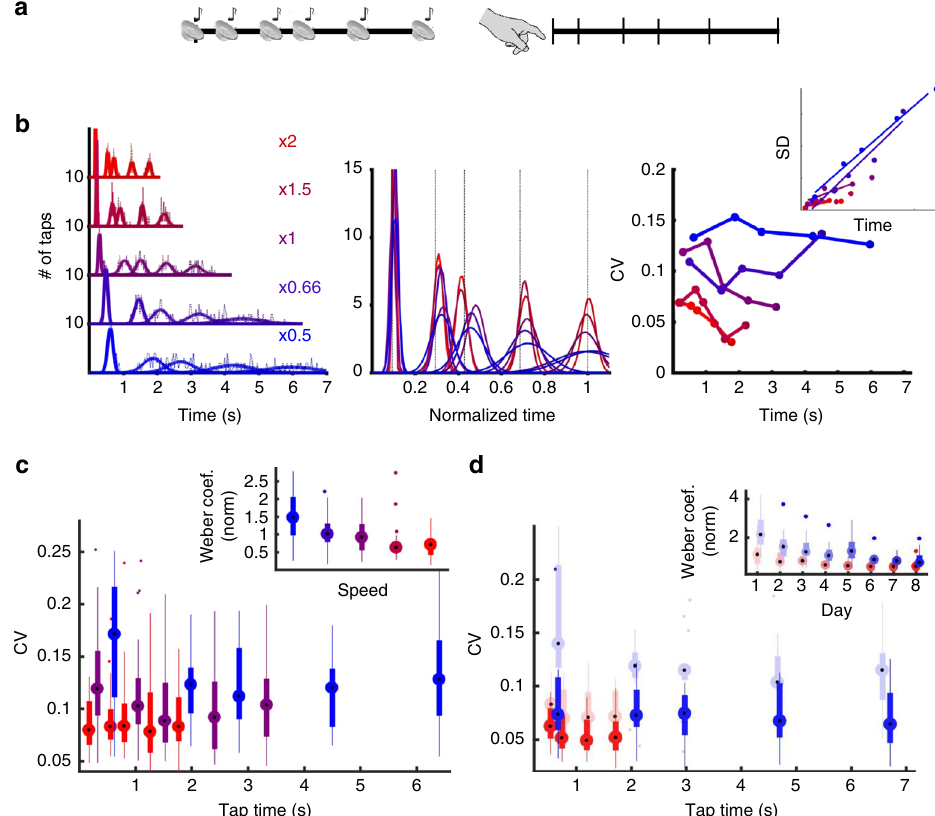
Fig. 5 Test of the Weber-Speed effect prediction. a Subjects were trained on an auditory temporal pattern reproduction task, using the same aperiodic pattern and same fi ve speeds used to test the RNNs. b Left: Histogram (dashed lines) and Gaussian fi ts (solid lines) of the cued taps at all fi ve speeds from a single subject (bin sizes scale with target duration). Middle: the fi ts shown with time normalized to the mean of the last tap (vertical lines represent target times) — note that the scaled fi ts do not overlap as expected by Weber ’ s law. Right: CV of each tap at each speed, with SD vs. mean time inset. The slope of the linear fi t of the variance vs. t 2 corresponds to the Weber coef fi cient (SD vs. time is shown for visualization purposes). c Whisker plots of the CV of all subjects ( n = 25) for three of the fi ve speeds (0.5×, 1×, and 2×). Note that, as in the RNN model, the CV at the same absolute time is higher at slower speeds. Inset shows the Weber coef fi cient for all fi ve speeds. d The Weber-Speed effect is not due to inexperience with the task. A subset of 14 subjects were trained to produce the 0.5× and 2× slow speeds over eight additional days. The Weber-Speed effect persists over the course of training. CVs are shown for the fi rst (light) and last (dark) day of training for both speeds. Inset: the Weber coef fi cients across all 8 days of training. Whisker plots show the median, lower and upper quartile, 1.5× interquartile range, and outliers. The color scheme is that same as in Fig.